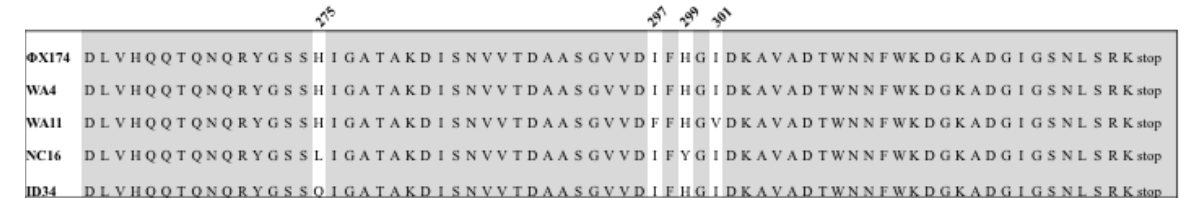
Figure 4. Percent inhibition (calculated as described in Methods) for all assayed phages grown in the presence of each reduction sequence. Least inhibited phage–reduction sequence pairings are shown in white, while the most inhibited phage–reduction sequence pairings are shown in red.